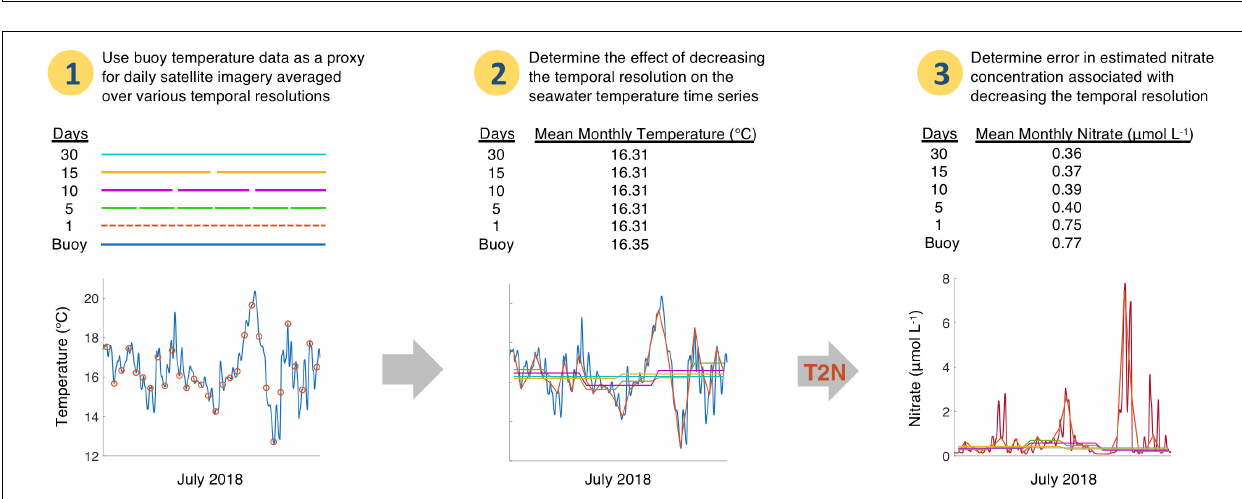
FIGURE 2 | Description of the two methods of estimating nitrate from sea surface temperature (SST) imagery for the Santa Barbara Channel region using Landsat 8 thermal images from October 22, 2017. Method 1 preserves the magnitude of nitrate estimations at the native 100 m scale by first passing the SST data through the empirical temperature to nitrate (T2N) relationship, then degrading the spatial resolution. Method 2 approximates a data user selecting a SST product at a commonly available spatial resolution and then applying the T2N relationship. The bottom rows show the difference in estimated nitrate concentrations between Method 1 and 2 at each spatial resolution.